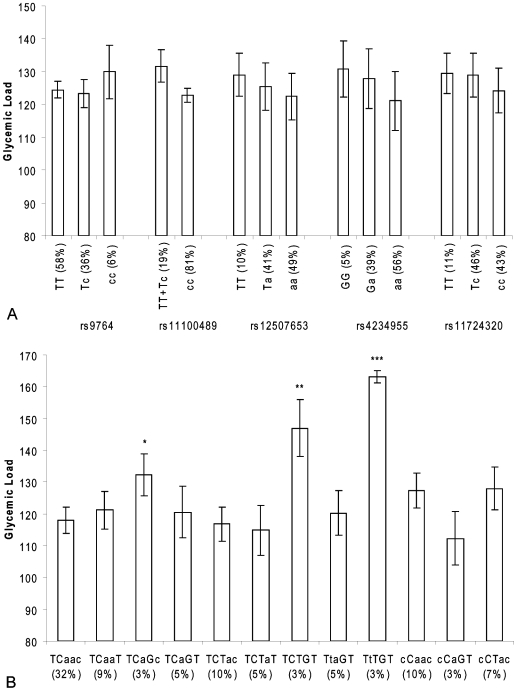

NPY1R/NPY5R variants and dietary glycemic load in the Hamlet population.Figure 6a shows the association of SNPs in the NPY1R/NPY5R region with dietary glycemic load. The ancestral alleles are indicated as capital letters. Figure 6b shows the association of NPY1R/NPY5R haplotypes with dietary glycemic index. The haploblocks consist of the SNPs rs9764, rs11100489, rs12507653, rs4234955 and rs11724320 and the ancestral alleles are indicated as capital letters. *p<0.05, **p<0.001, ***p<0.0001 (compared with linear regression model).